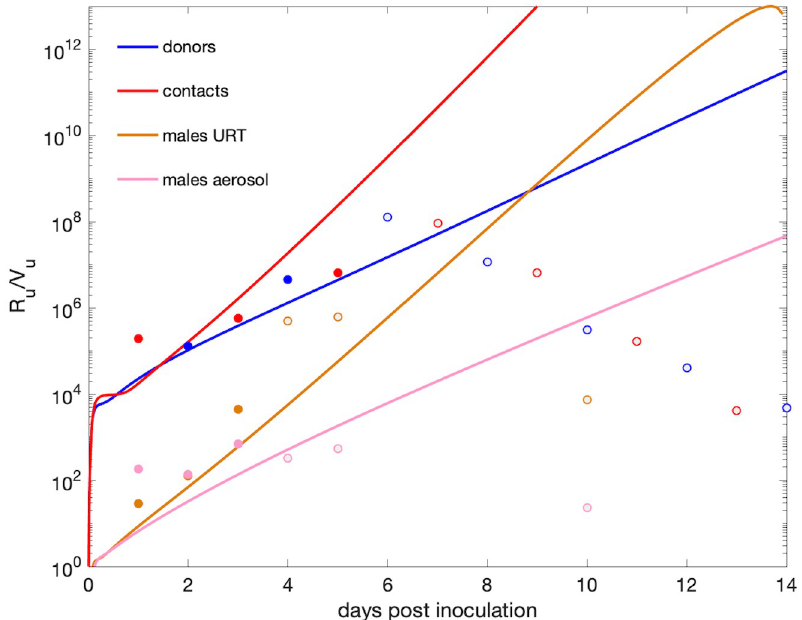
Fig 7. Ratio of total RNA to infectious virus over time. R contacts (red), males URT (gold), and males aerosols (pink) hamsters. The light data points correspond to data where the infectious virus is at the limit of